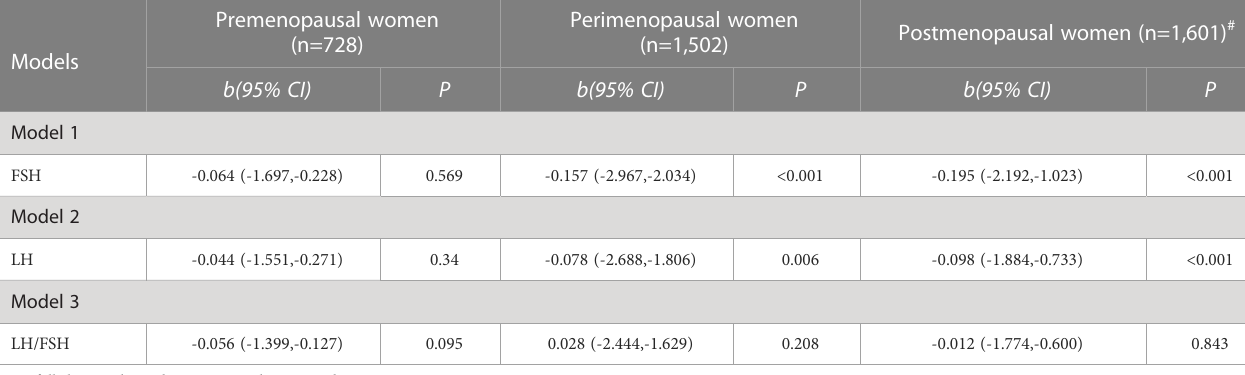
TABLE 4 The associations of FSH, LH, and LH/FSH with metabolic syndrome severity score ※ .